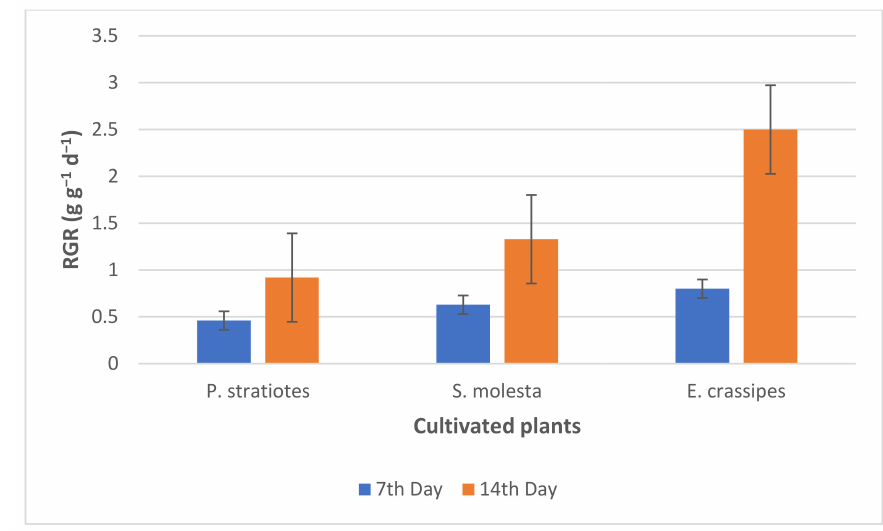
Figure 5. Graph of RGR (g g − 1 d − 1 ) against cultivated plants at 24 h retention